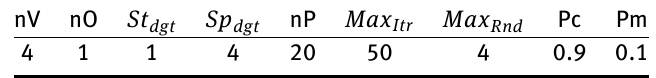
Table 9: VSSCGA Settings for Ackley’s function with 4 variables